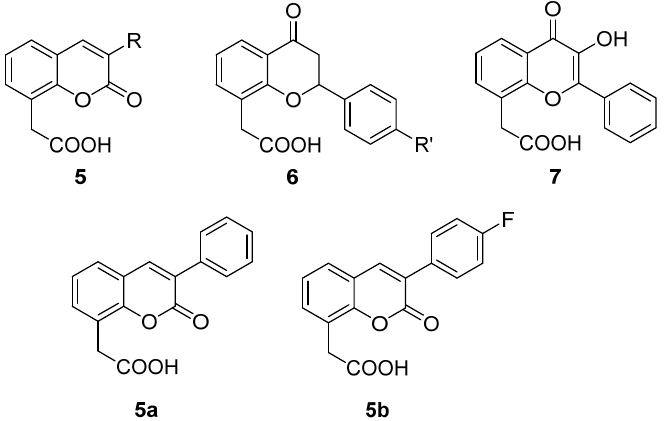
Figure 4. Naturally-inspired coumarin-, flavanone- and flavonol-based FAA derivatives.